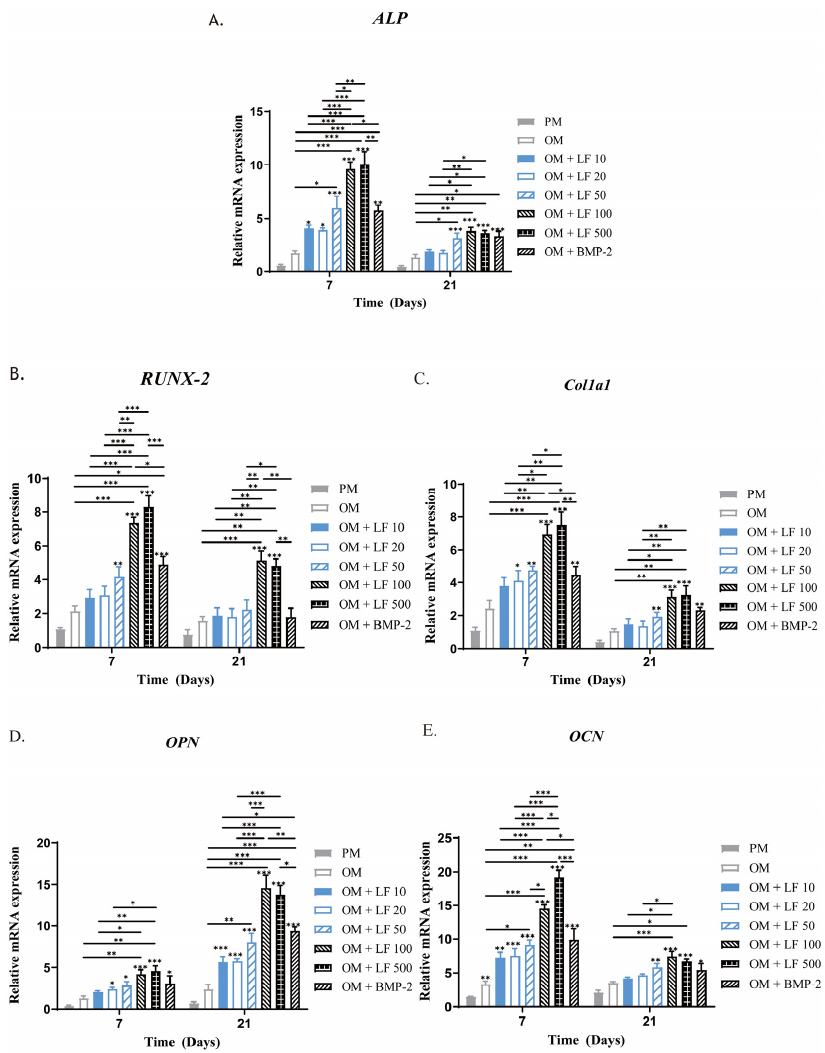
Figure 5. Analysis using quantitative RT-PCR of osteogenic gene expression in ADSCs exposed to LF at various doses and BMP-2 on days 7 and 21. ( A – E ) ALP, RUNX-2, COL1a1, OPN, and OCN expressions, respectively. All of the osteogenic marker genes ( A – E ) were upregulated in the LF and BMP-2 groups. Comparatively, the highest gene expression levels were stimulated by LF at 100 and 500 μ g/mL. On the top of a column without a capped line, seven OM groups’ significance levels are compared with that of PM group (* p < 0.05, ** p < 0.01, and *** p < 0.001).